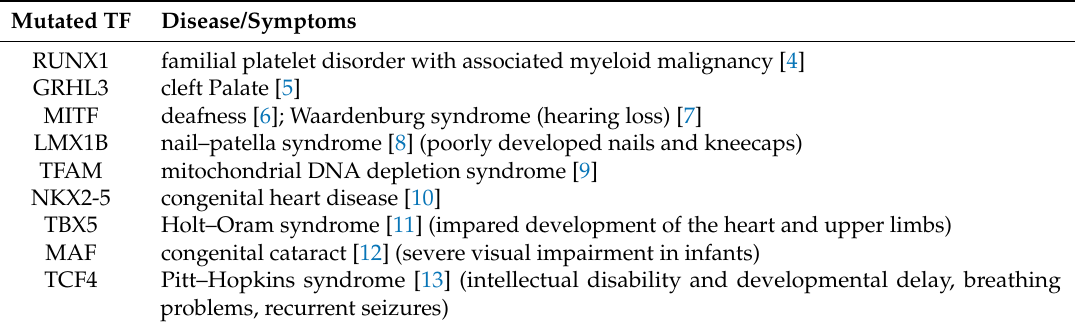
Table 1. Examples of diseases caused by mutations in a transcription